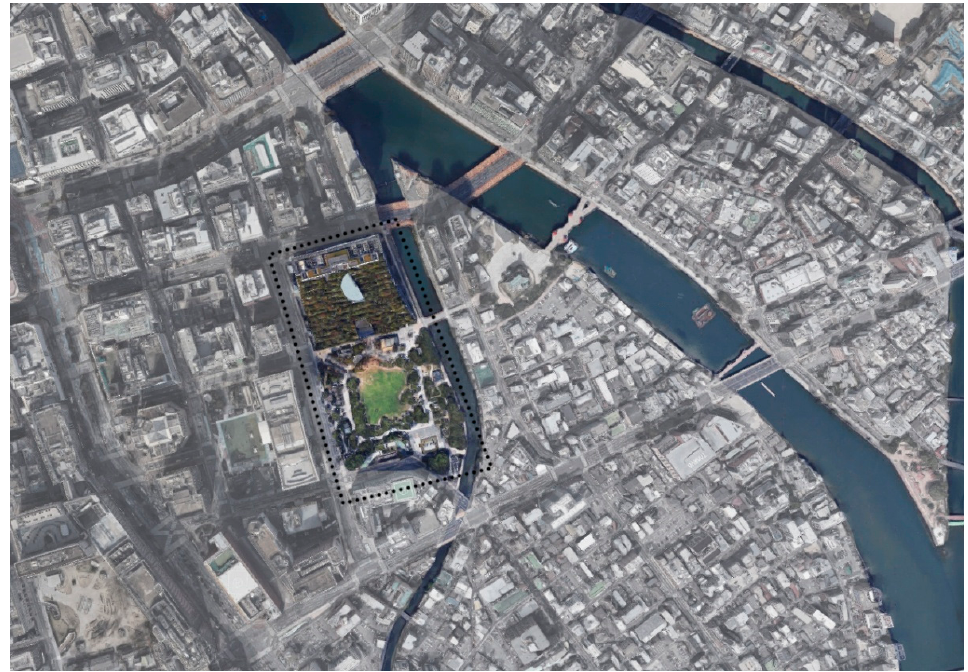
Figure 3. Context of the Prefectural International Hall “Asian Cross Road Over the Sea”; graphic processing, based on Google Maps and [19], by E. Latusek.